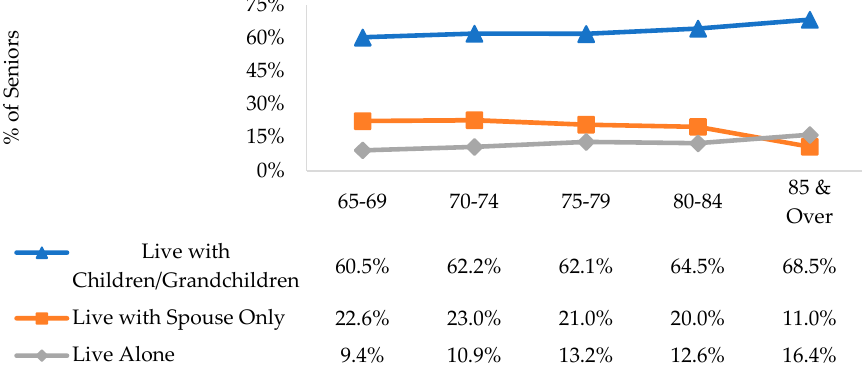
Figure 2. Age-specific proportion of seniors by living arrangements in 2014.